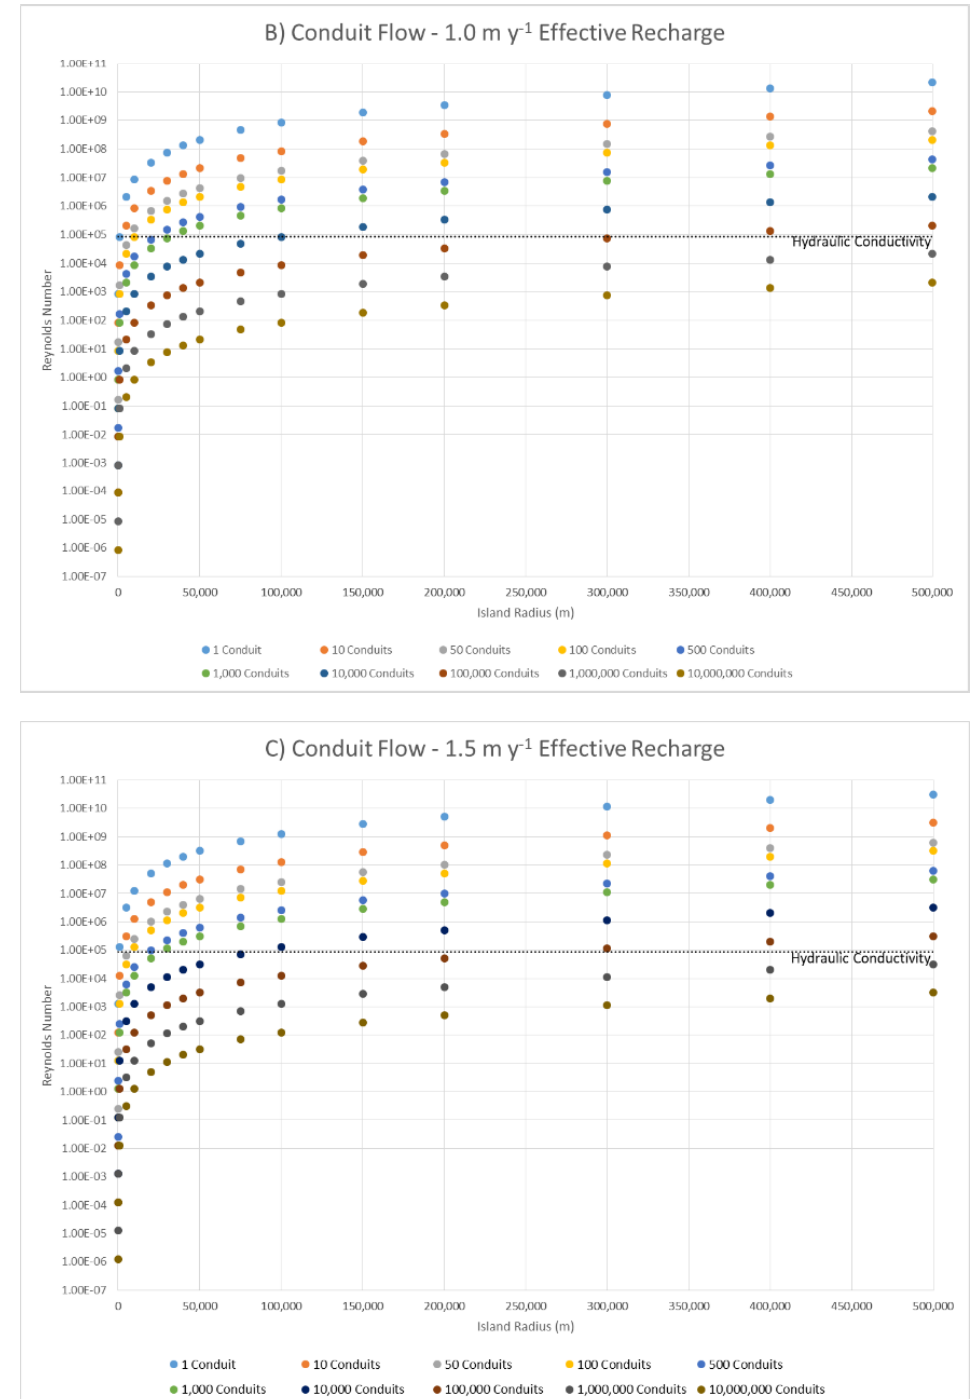
Figure 13. The conduit flow (radius = 0.75 m) trial Reynolds numbers plotted against island size (scatter plot). Note that for small island sizes, the Reynolds numbers are plotted below the hydraulic conductivity suggested by Whitaker and Smart [28] (the horizontal line), 5000 m day −1 , whereas for the larger island sizes, the Reynolds numbers are plotted above the hydraulic conductivity. ( A ) Assuming a recharge rate of 0.5 m y −1 . ( B ) Assuming a recharge rate of 1.0 m y −1 . ( C ) Assuming a recharge rate of 1.5 m y −1 . Note that as recharge increases, the Reynolds numbers increase slightly; however, the effect is minimal.